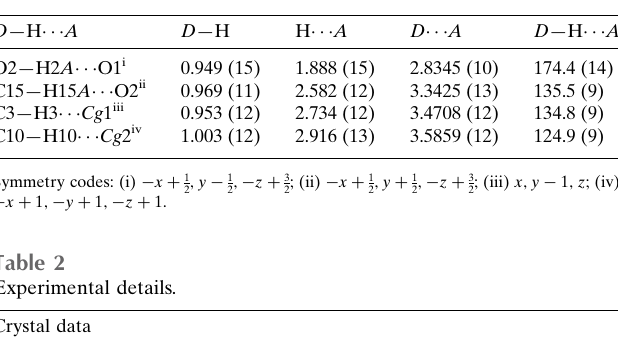
Hydrogen-bond geometry (A˚ , (cid:3) ).